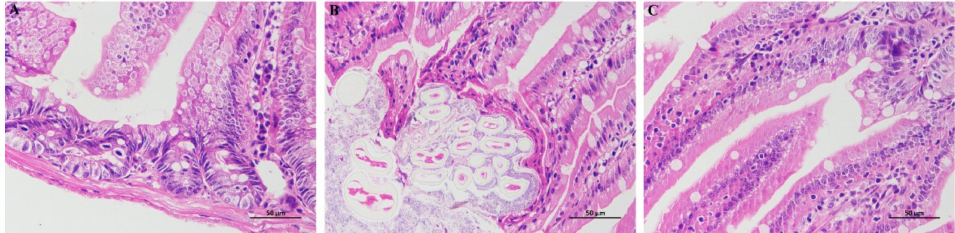
Figure 5. Histogram of metabolic pathway impact factors. ( A ) Histogram of metabolic pathway in BG vs. MG groups; ( B ) Histogram of metabolic pathways in MG vs. DG groups.